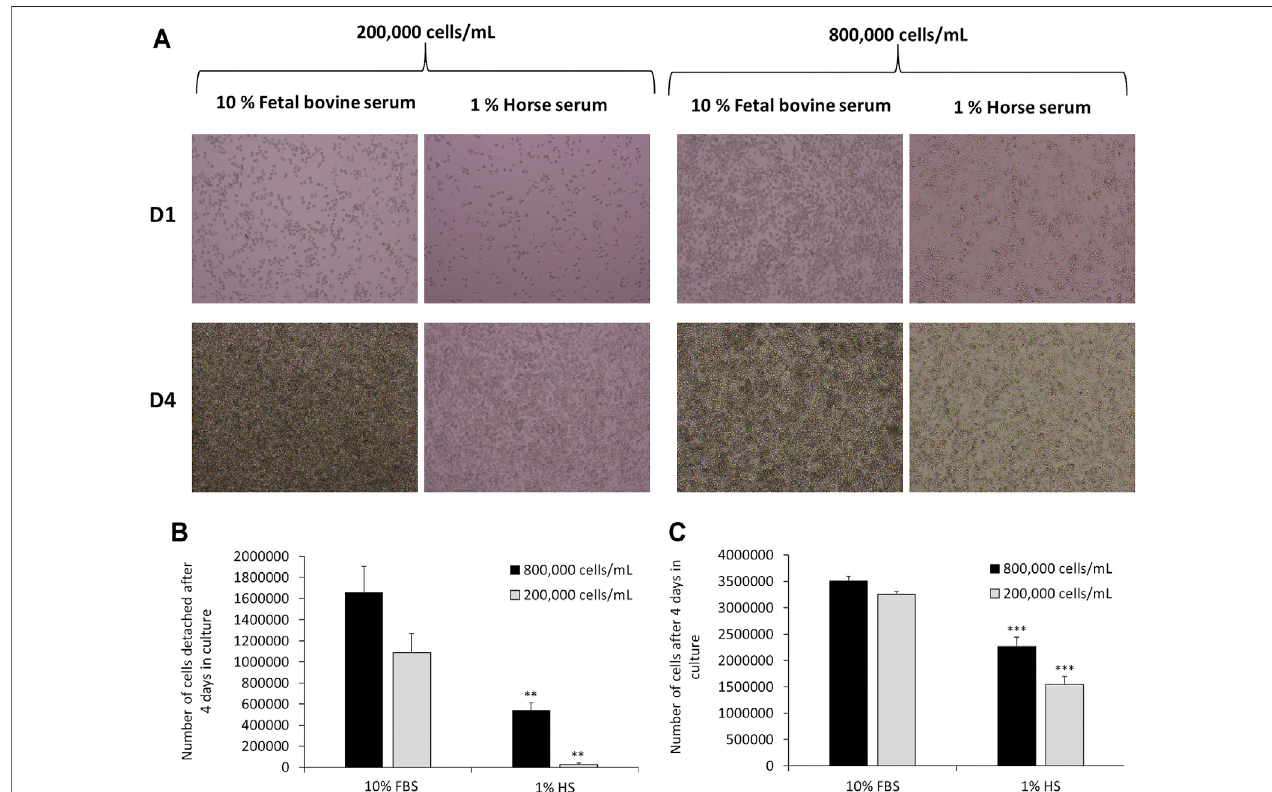
FIGURE 2 | Comparison of cell culture medium for J774 cells after 4 days in culture medium. Panel A- Microscopic observation of J774 cells after 1 day (D1) or 4 days(D4)inculturemedium.Cellculturemediumtested:DMEM+10%FetalBovineSerum(FBS)andDMEM+1%HorseSerum(HS).Theseedingtestedwas200,000 cells/mL or 800,000 cells/mL. Panel B- Quanti fi cation of detached cells in the supernatant via cell numeration. Quanti fi cation of adherent cells via crystal violet (N (cid:1) 3). *, signi fi cant difference between the 10% fetal bovine serum and 1% horse serum conditions. Number of symbols: 2: p < 0,01, 3: p < 0.001.